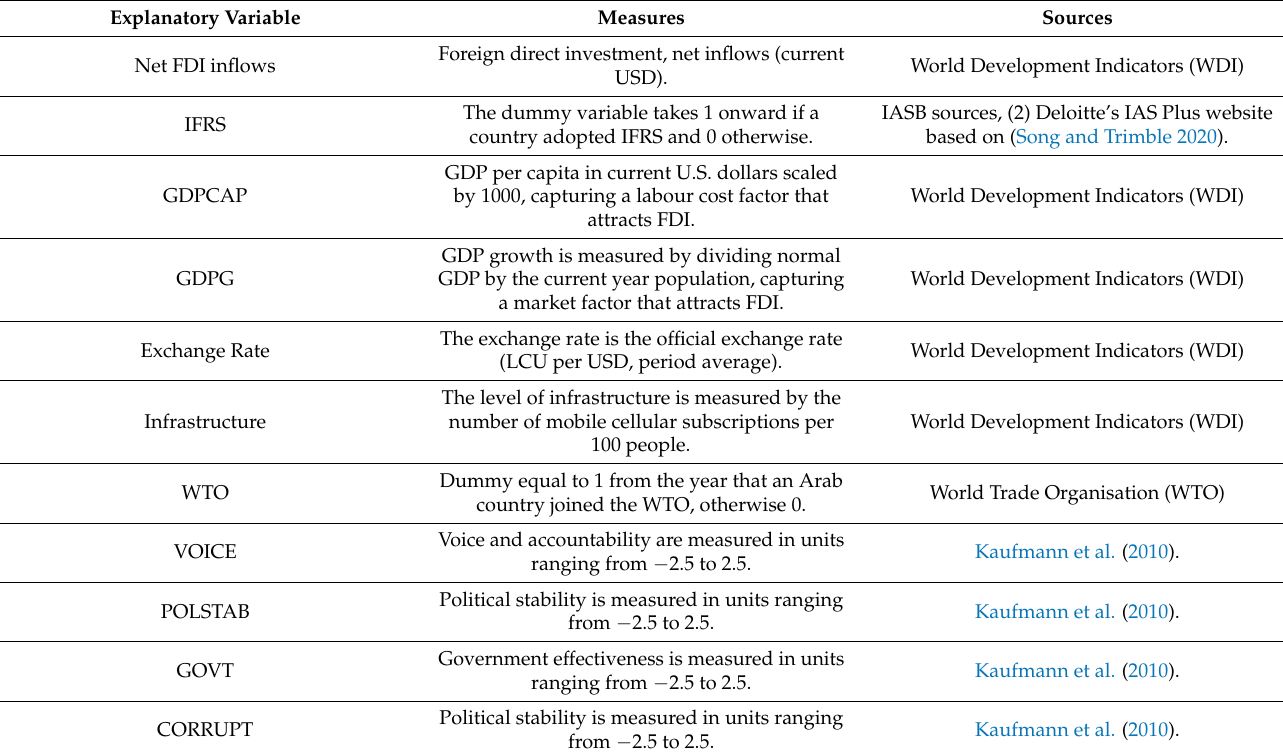
Table A2. Variable description, measurement and data